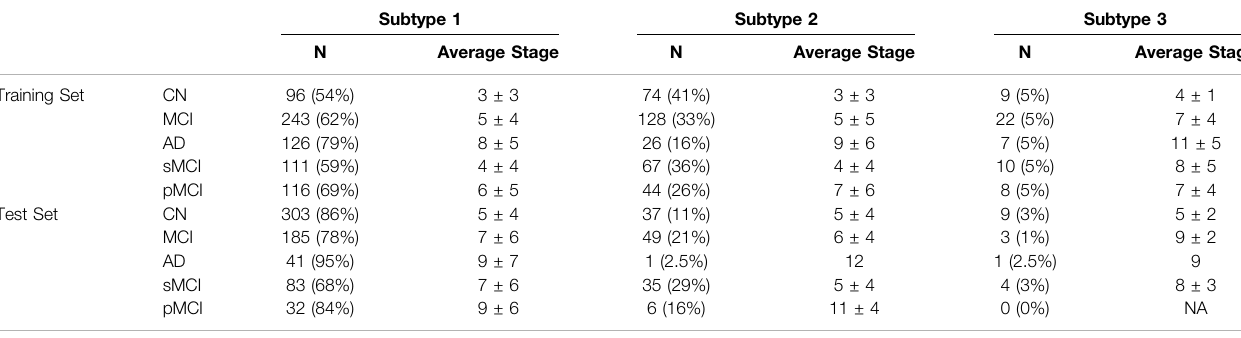
TABLE 3 | Number and percentage of subjects from each diagnostic category assigned to each subtype.